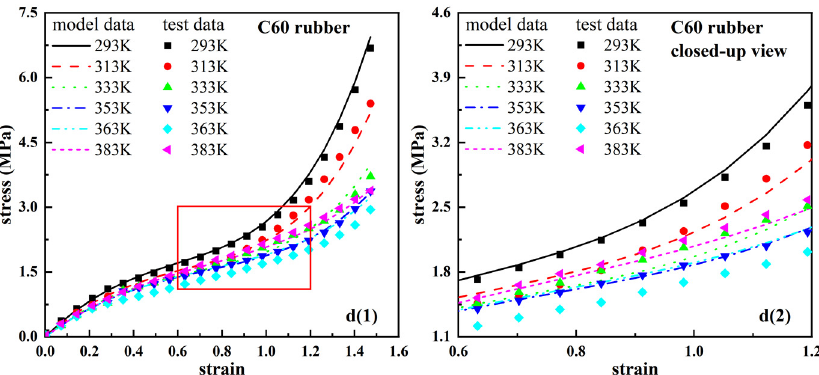
Figure 7. Model stress–strain curves of four types of rubbers at different temperatures based on the Yeoh constitutive model with the explicit temperature parameter. ( a1 , b1 , c1 , d1 ): model curves and experimental data of four types of rubbers; ( a2 , b2 , c2 , d2 ): corresponding local closed-up views.